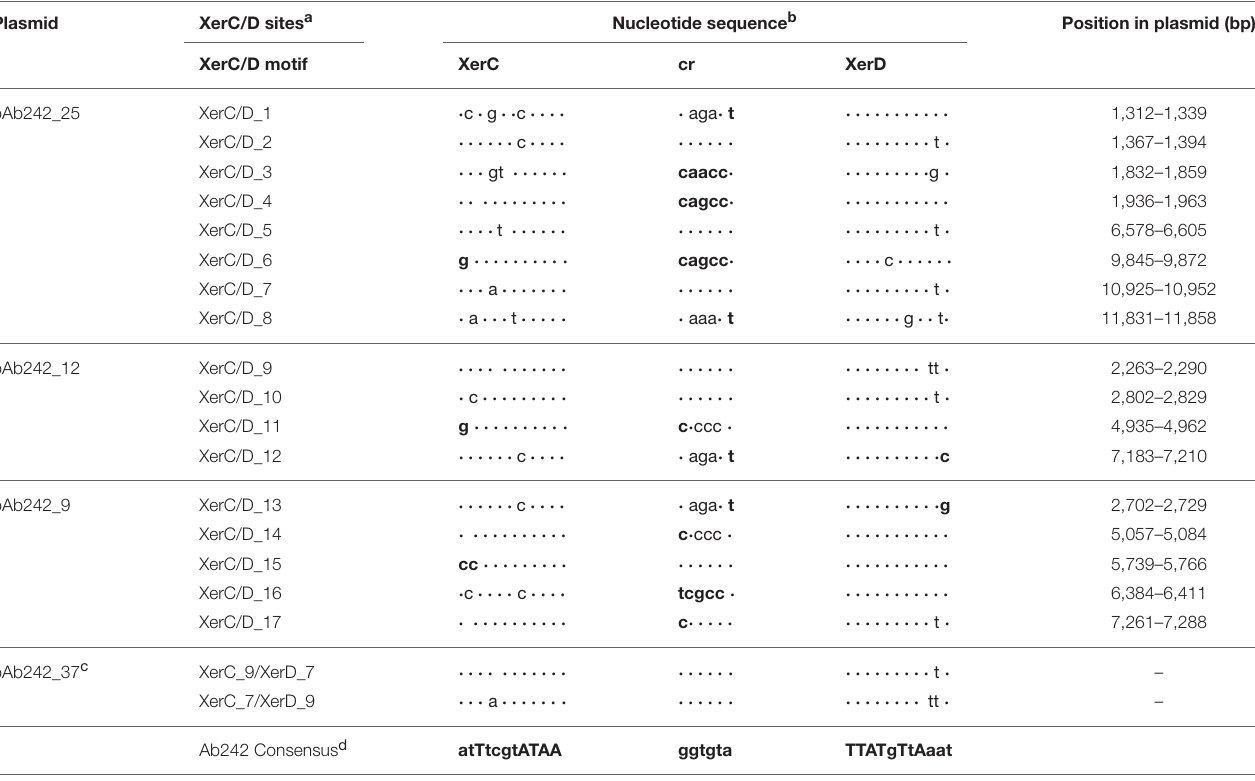
TABLE 2 | XerC/D-like recognition sites found in Ab242 plasmids.